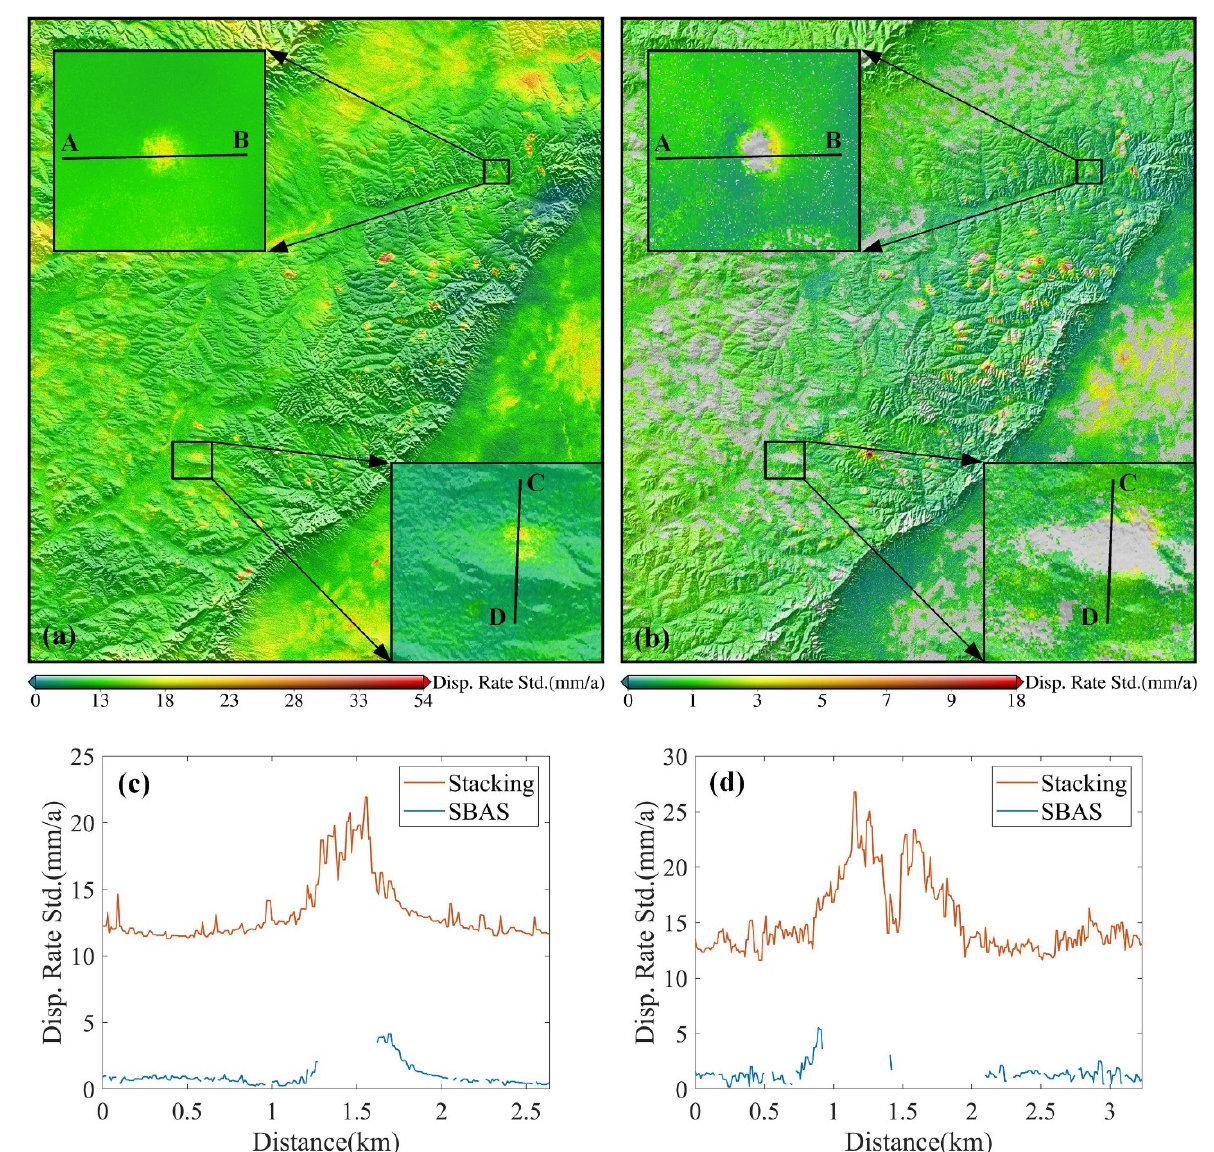
Figure 11. Images ( a , b ) are the stacking-InSAR and SBAS-InSAR displacement rate standard devia- tion; ( c , d ) are the standard deviation of the displacement rate on section lines AB and CD.